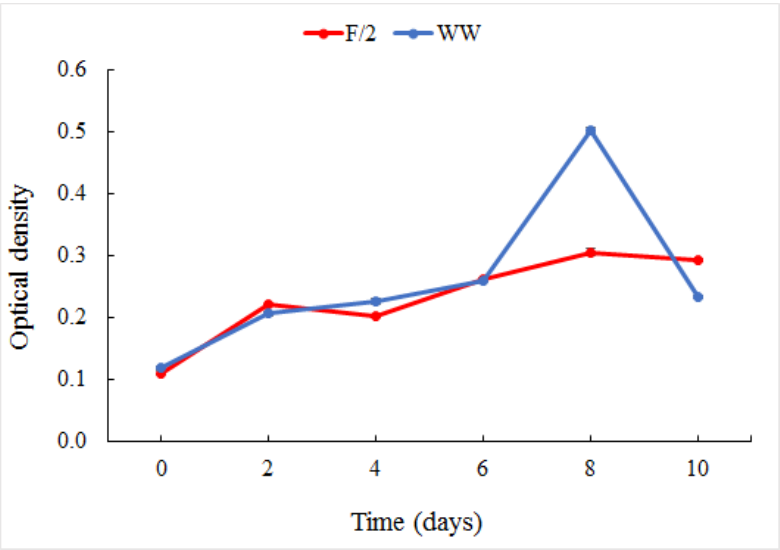
Figure 6. Changes in optical density during cultures of Chlorella minutissima (mean ± SD; F/2— synthetic medium, WW—wastewater).